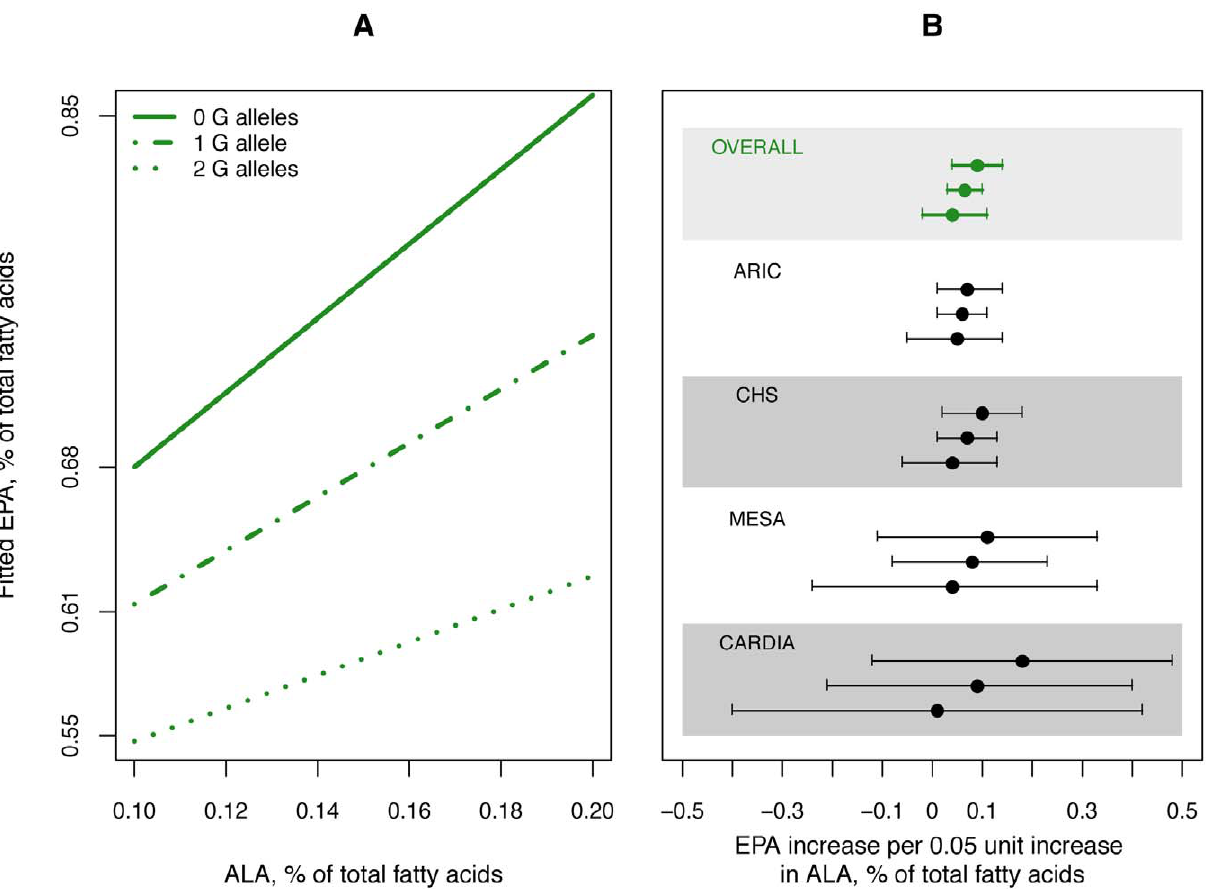
Figure 5. Influence of variation in rs1535 on the estimated association of plasma phospholipid ALA levels with EPA levels. Panel A illustrates the association of ALA with EPA in carriers of 0, 1, and 2 copies of rs1535 G allele with fitted lines constructed from meta-analyzed estimates. Panel B shows the % change in EPA corresponding to a 0.05 unit increase in ALA in carriers of 0 (top estimate), 1 (middle estimate), 2 (bottom estimate) copies of rs1535 G allele.